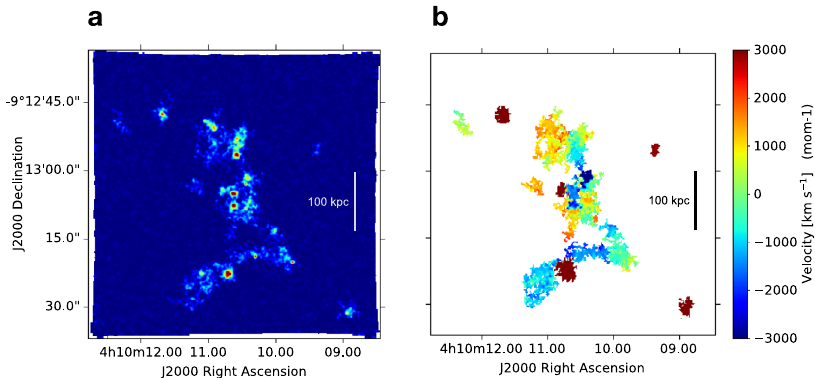
Fig. 3 | Morphologically disturbed and fi lamentary distribution of gas in the surroundings of W0410-0913. In panels a , b we show a composition of the optimally extracted Lyman- α fl ux maps and kinematic maps of galaxies in the overdensity,respectively,obtainedbycomputingthemoment-0andmoment- 1 of the voxels detected in their 3D-segmentation-masks (see subsection A